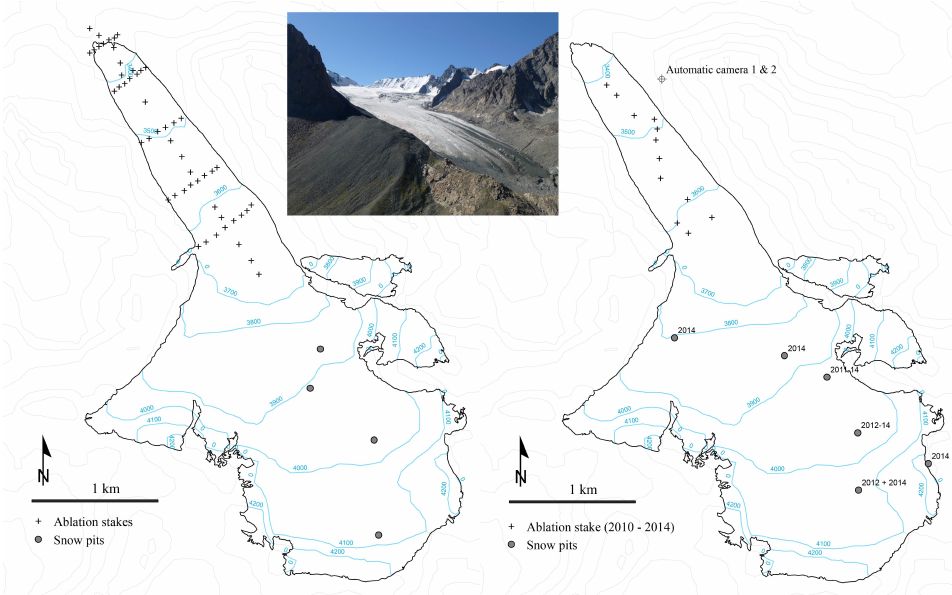
Figure 2. Left : historical (1969–1994) and right : reestablished (2010–present) monitoring network. The inset shows an image of Golubin taking in